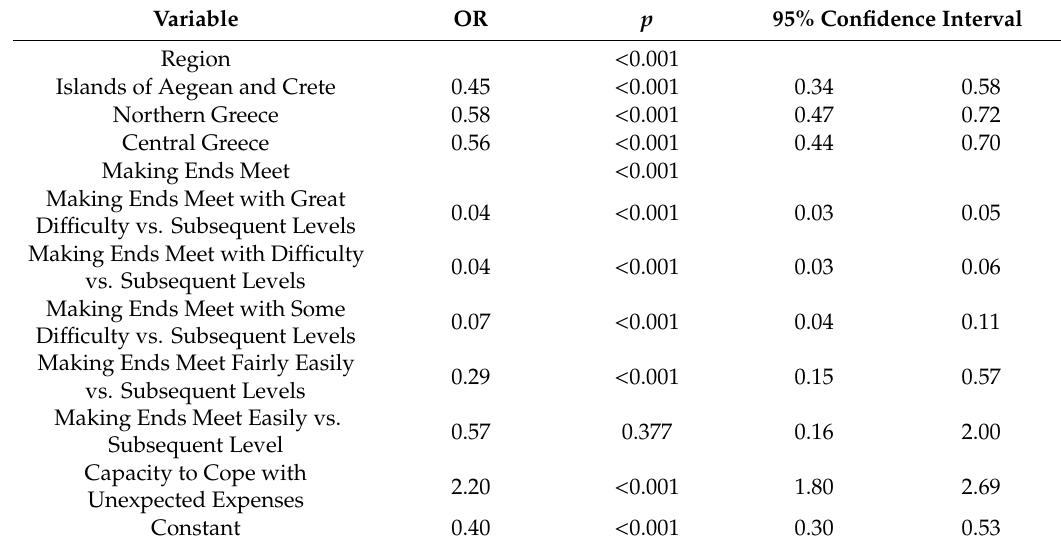
Table 5. First model (logistic regression